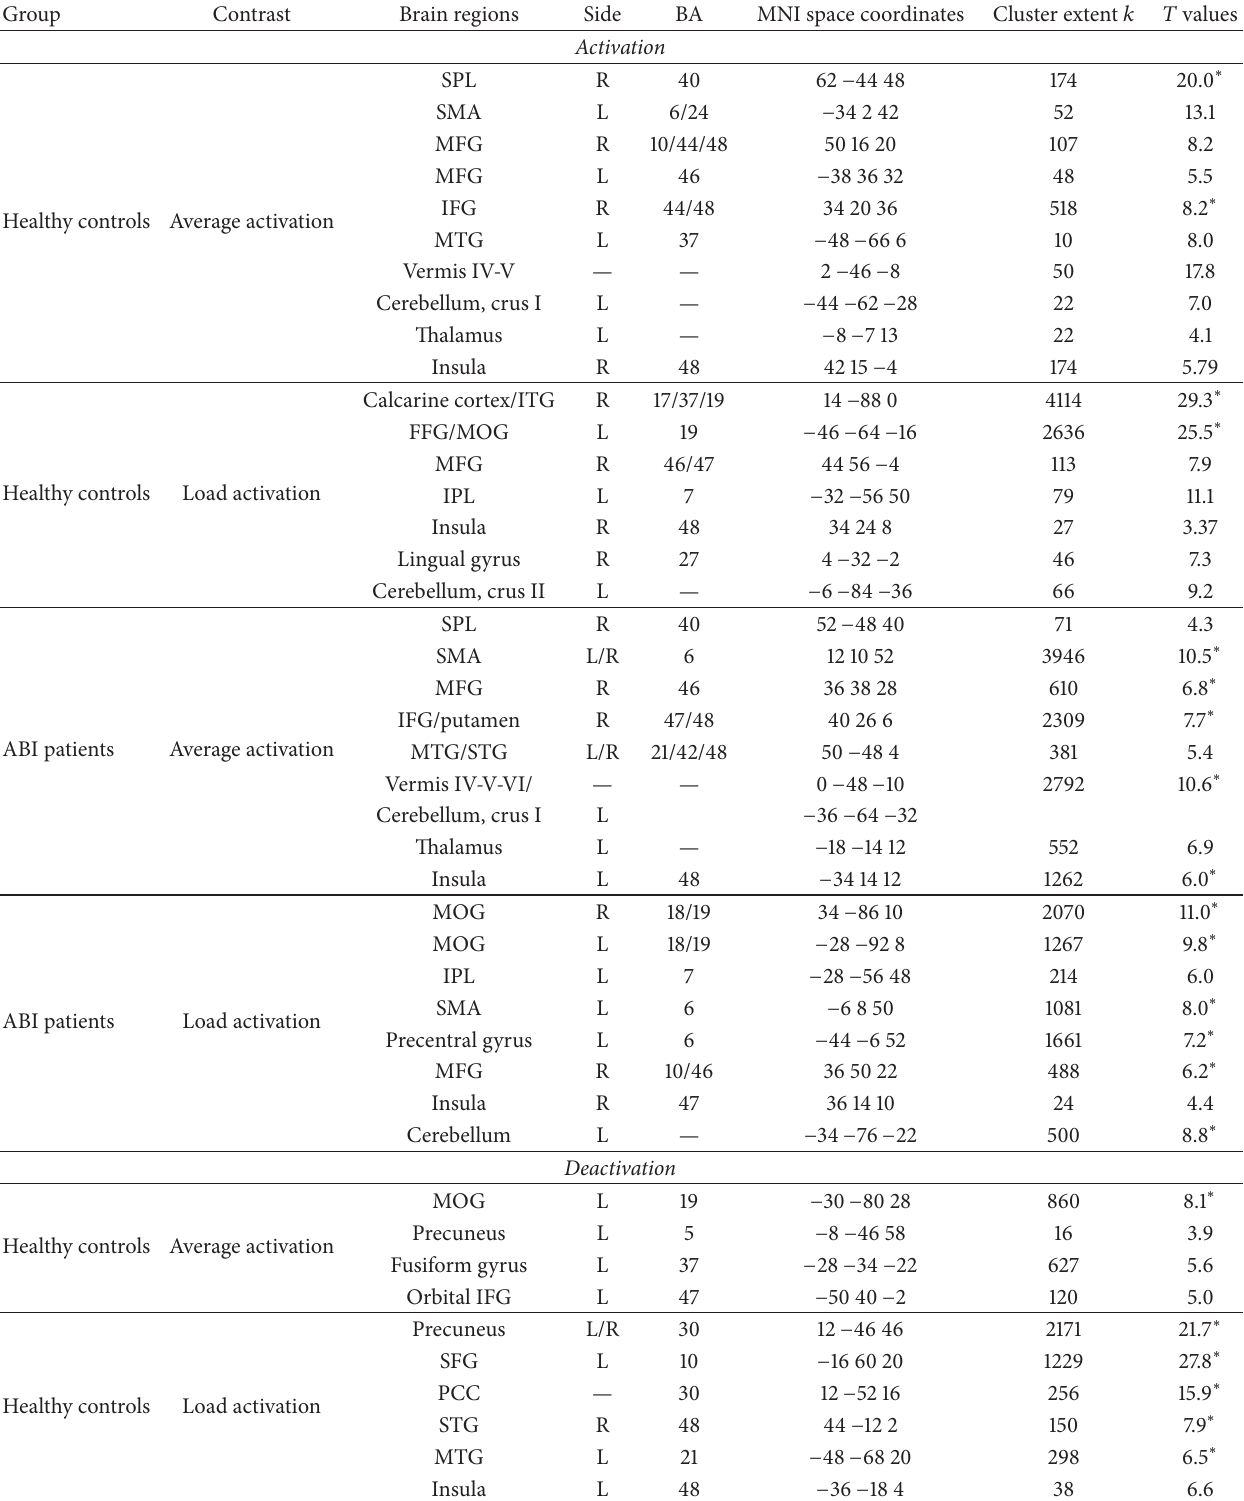
Table 2: Brain regions significantly activated/deactivated during fMRI with the modified Conners Continuous Performance Test (CCPT) task (average and load conditions) in healthy controls and patients with acquired brain injury (ABI) (one-sample 𝑡 -test, 𝑝 < 0.001 ). Group Contrast Brain regions BA